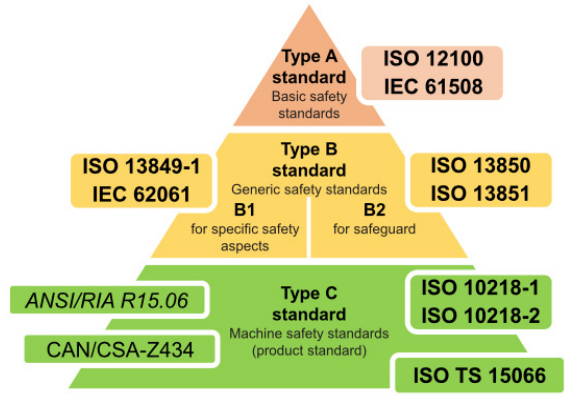
Figure 1. Robotic safety standards categories [2] Approaches for Safety and Cyber Security